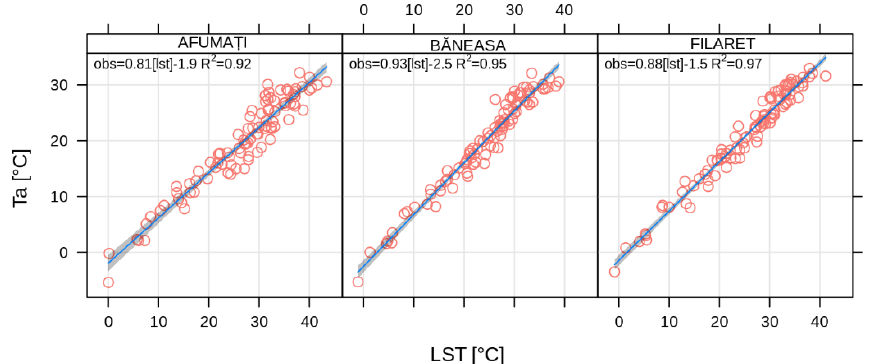
Figure 13. Ta versus LST values retrieved from Landsat 8 over the pixels corresponding to the Bucharest weather stations (2013–2018).